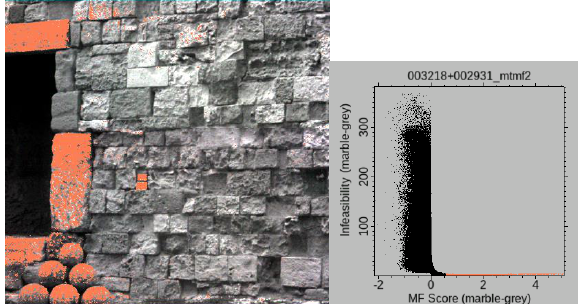
Figure 10 . Paint in orange are the pixels which are selected for marble MF score > 0.5 and marble infeasibility < 20